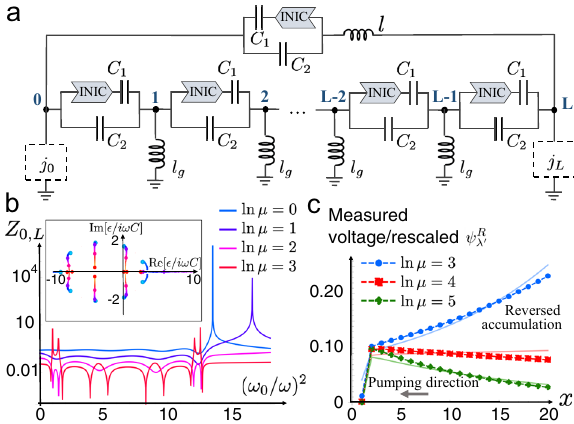
Fig. 5 Circuit realization and simulated measurements of scale-free state accumulation. a The circuit of Eq. (8), whose asymmetric couplings are implemented through a negative impedance converter with current inversion (INICs) and capacitors. The extra variable inductor l gives rise to a coupling "impurity ’’ . Suitably designed grounding elements (see the “ Methods ” section) enable desired eigenstates to be isolated at appropriate driving voltage frequency ω . b Simulated impedance measurements across the impurity at various impurity strength μ , with position ω and height of impedance peaks loosely corresponding to the real and imaginary parts of the spectrum ϵ /( i ω C ) (inset). Here the capacities of C 1 and C 2 are parameterized as C 1 ¼ C sinh α , C 2 ¼ C cosh α . Parameters used are L = 9, ffiffiffi p C = 1 and C = 3, so that C ¼ 8 and α = 0.364. c Simulated electrical 1 2 potential measurements vs. the pro fi le of the bulk eigenstate with largest ϵ / ( i ω C ), tuned close to resonance via Eq. (2). Not only is Eq. (7) accurate, the nature of eigenstate accumulation also agrees perfectly with the regimes of Fig. 1d. Parameters are L = 20, C 1 = 2.9, C 2 = 3, such that 2 α ≈